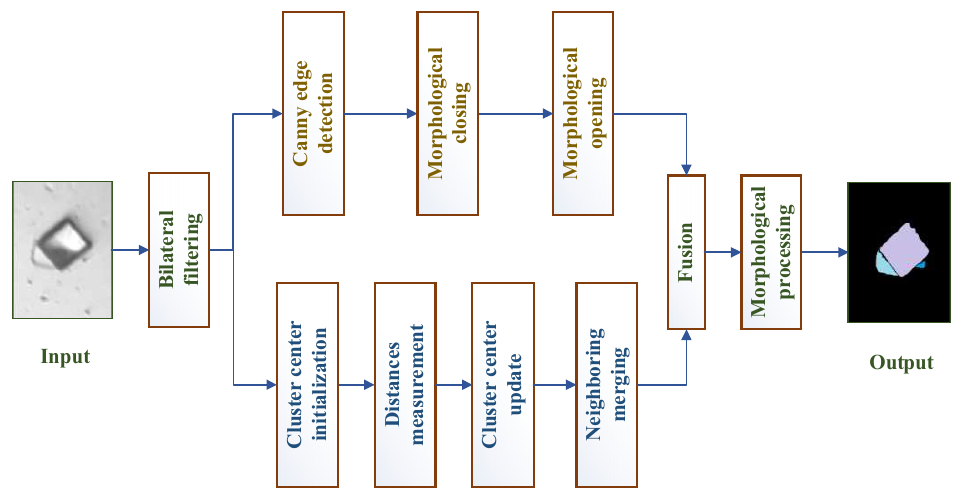
Figure 3. The illustration of the proposed segmentation algorithm.